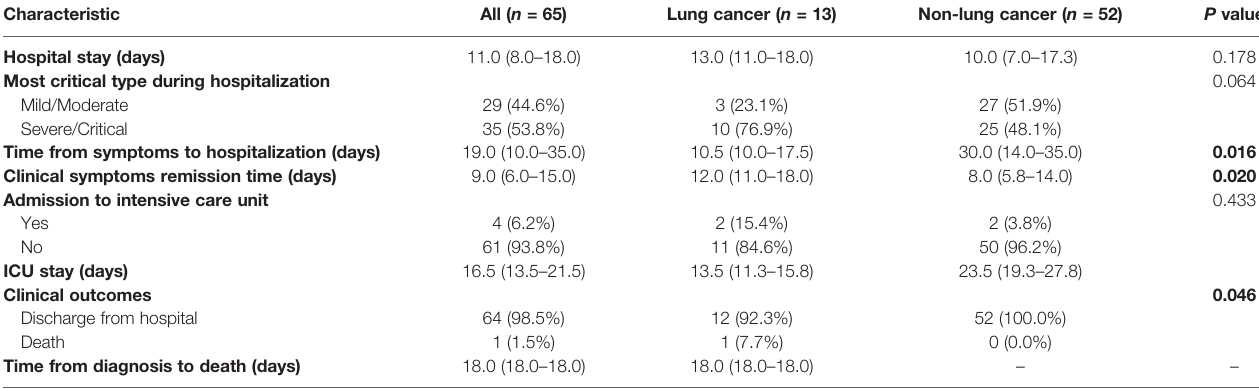
TABLE 2 | Outcome of lung cancer patients and general population.